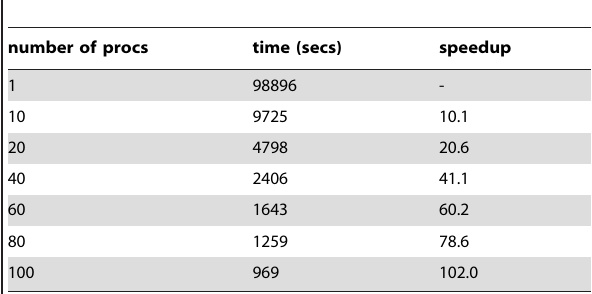
Table 2. Total execution times in